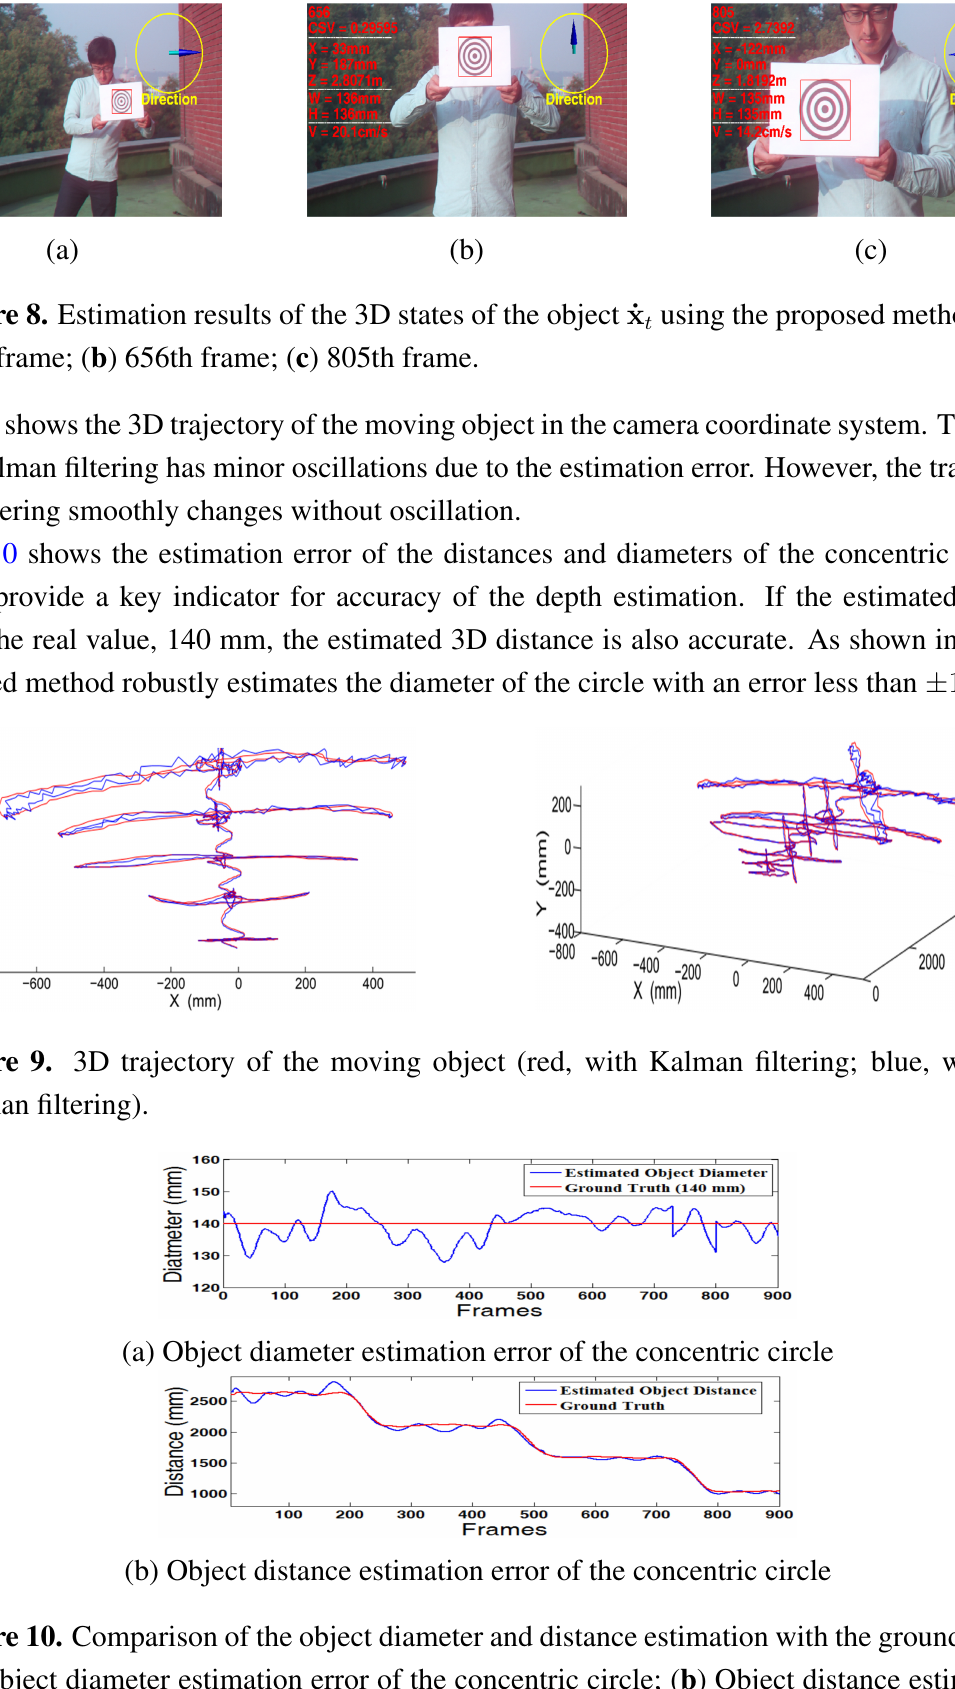
using the proposed method. ( a ) t